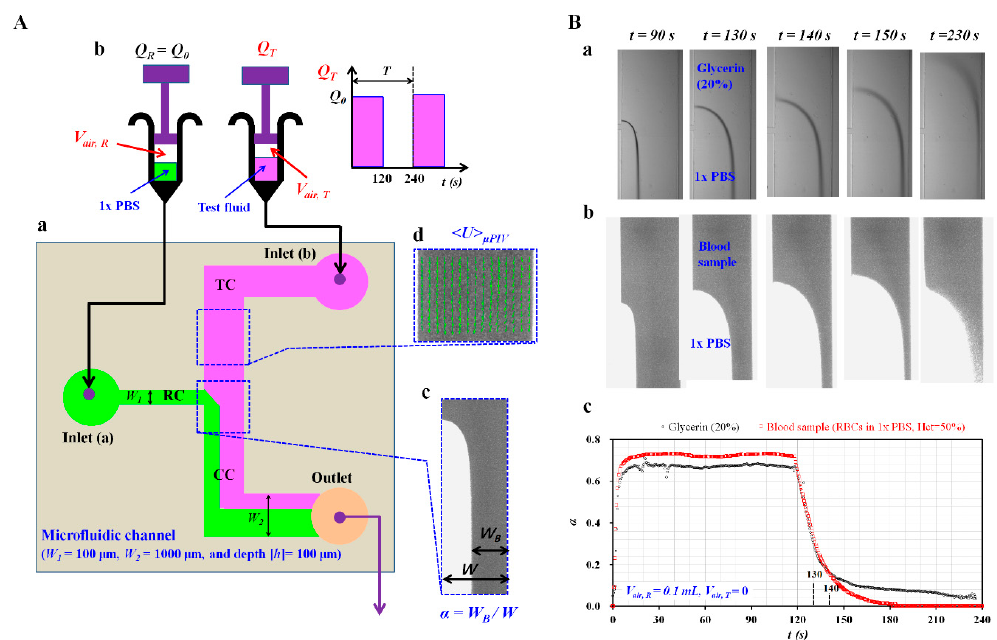
Figure 1. Proposed method for measuring the effect of air compliance on measurement of mechanical properties of blood samples flowing in microfluidic channels. ( A ) Schematic diagram of experimental setup including a microfluidic device, two syringe pumps, and an image acquisition system. (a) A